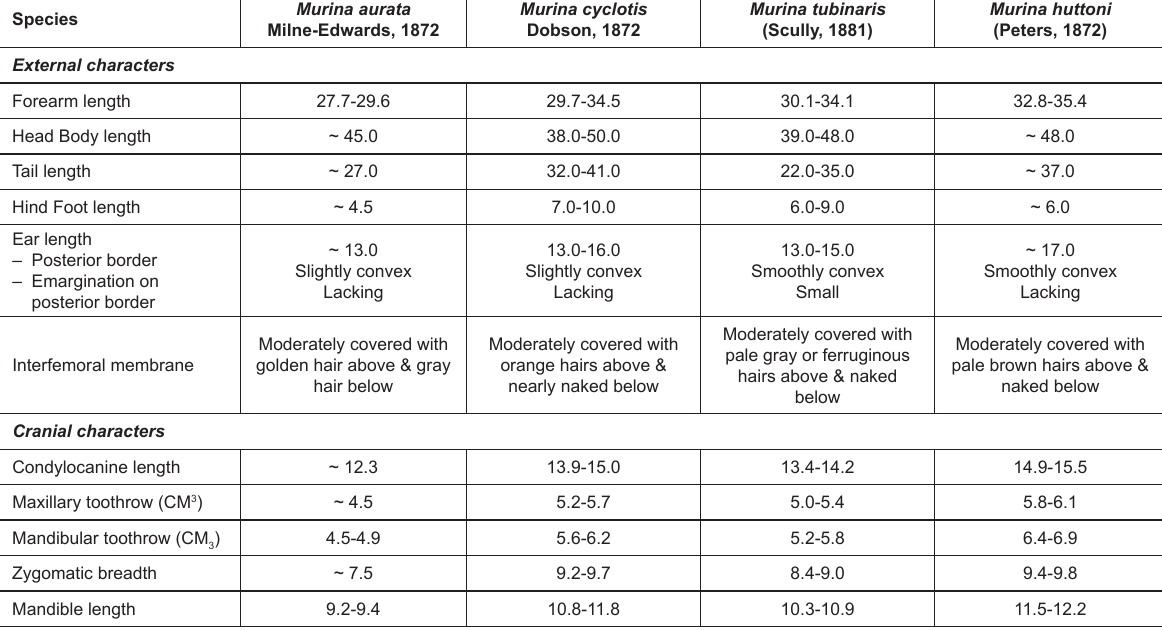
Table 7.1 (Contd..). Diagnostic morphological characters of the species belonging to the genus Murina present in South